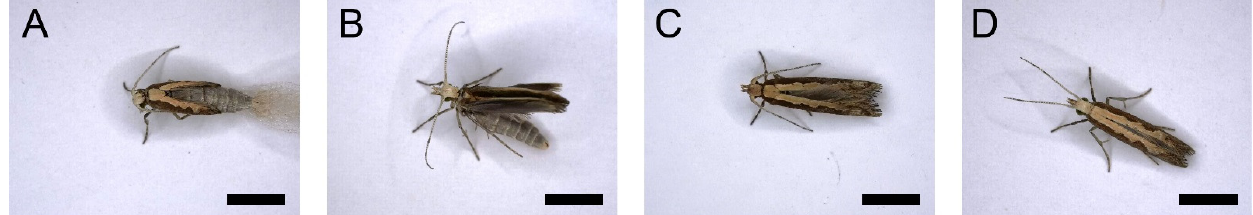
Figure 5. The post-eclosion behavior of P. xylostella moth. Scale bar = 500 μ m. n = 36. ( A ) Stage I: The newly molted adult remained stationary. ( B ) Stage II: Wing expansion. The wings erected vertically over the abdomen. ( C ) Stage III: The wings folded downward and covered the dorsum of the adult. Meanwhile, the antennae suddenly waved backward. ( D ) Stage IV: The antennae finally waved for- ward.